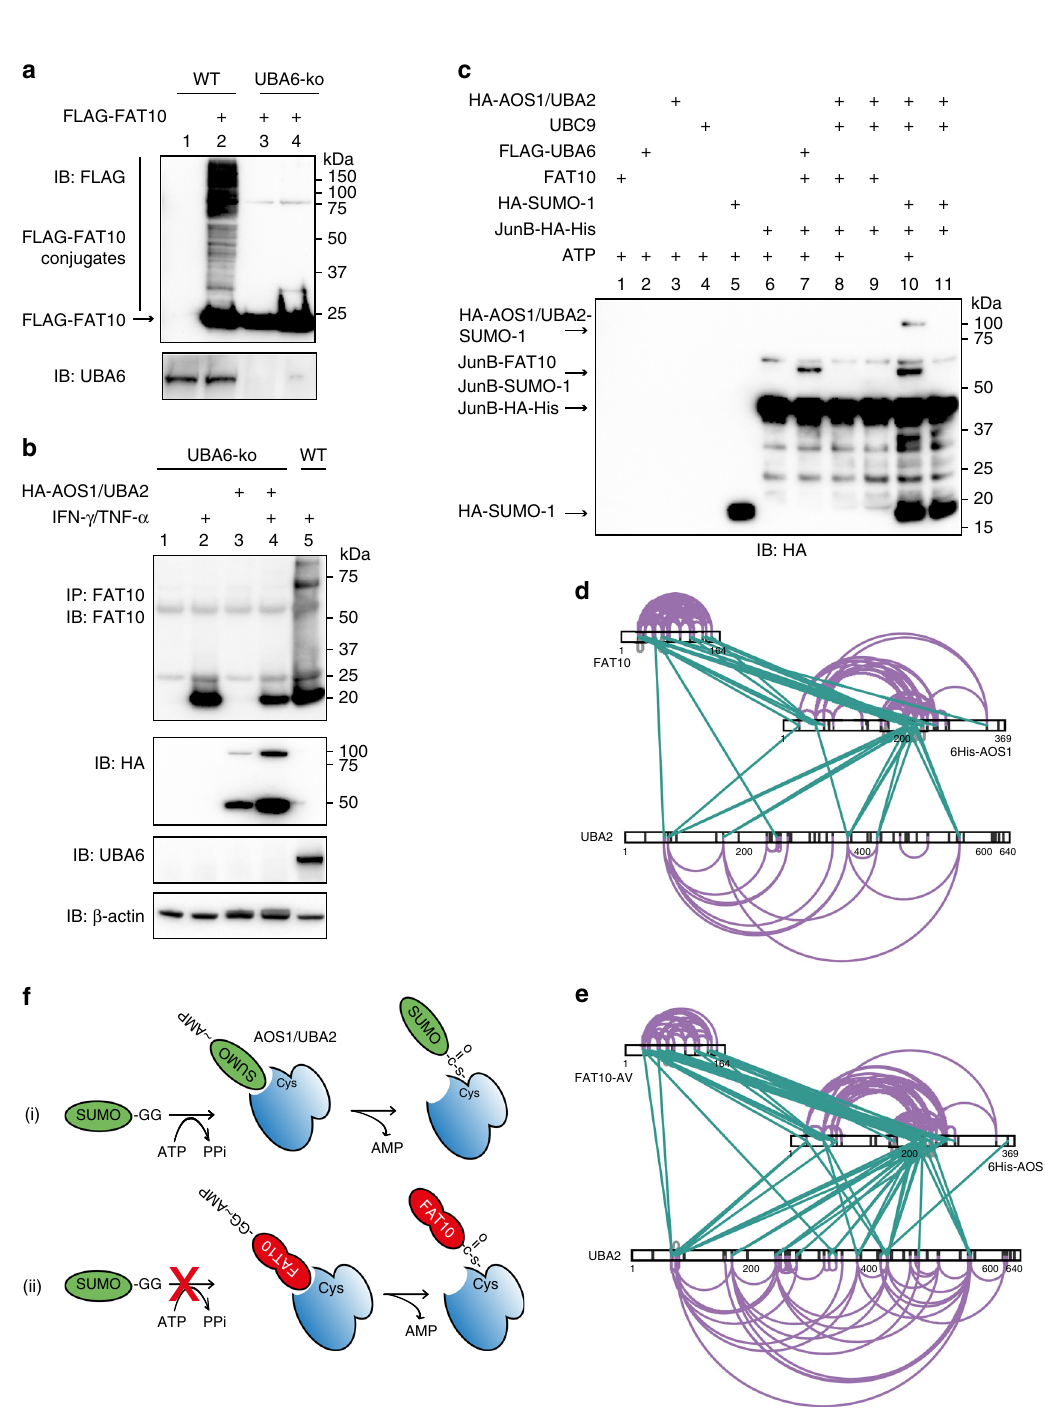
Fig. 6 FAT10 can be activated by AOS1/UBA2. a In vitro experiment showing SUMO-1 or FAT10 activation by AOS1/UBA2. Activation was performed in presence or absence of ATP, as indicated, under in vitro conditions with recombinant proteins for 30 min at 37 °C. Proteins were separated on 4 – 12% gradient gels (NuPage) and activation was visualized by western blot analysis under non-reducing (non-red.) or reducing (red.) (4% 2-ME) conditions using the antibodies indicated. b Same as in a but additionally with the FAT10 diglycine mutants FAT10 Δ GG and FAT10-AV. c Luminescence-based ATP consumption assay. Shown is the mean of fi ve independent in vitro SUMO or FAT10 activation assays performed as shown in a . The residual ATP was measured by an ATP consuming luciferase reaction. The single recombinant proteins in the absence of ATP (w/o ATP) were used as control. d Same as in a but additionally with the AOS1/UBA2 active-site mutant AOS1/UBA2-C173A and UBC9. The exact recombinant protein amounts used in each experiment can be found in the methods section. Each western blot panel shows one experiment out of three experiments with similar outcomes. Source data are provided as a Source Data fi